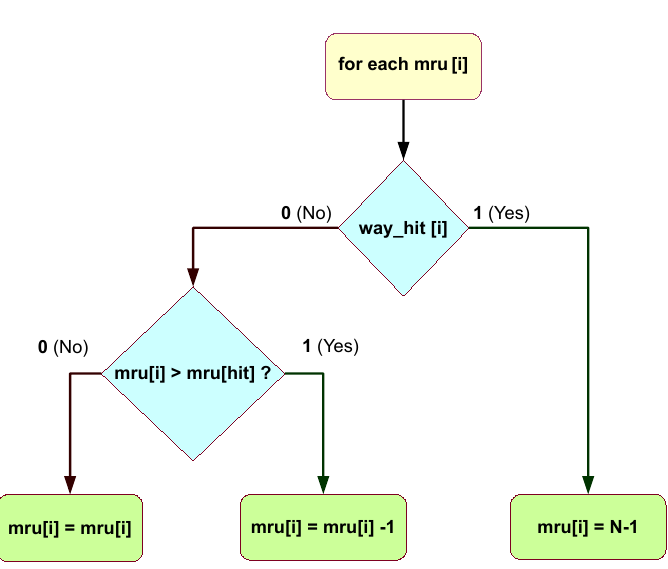
Figure 3. LRU Encoder datapath